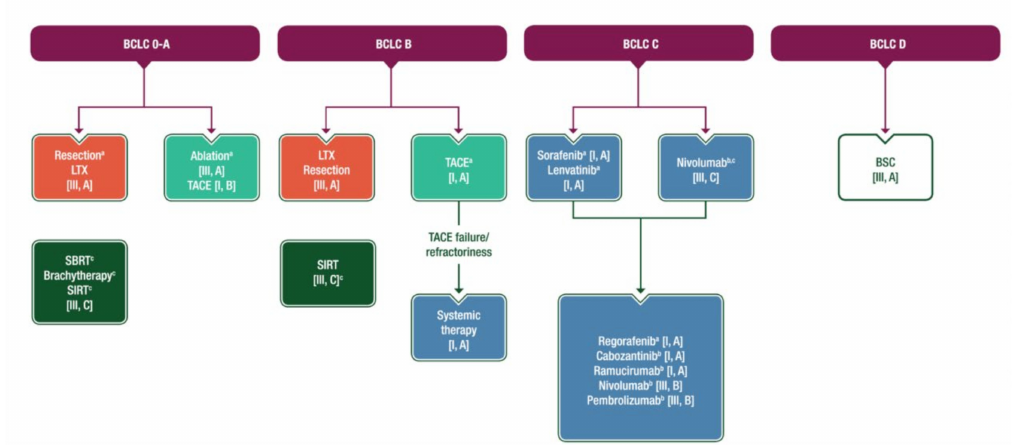
Figure 7. eUpdated European Society of Medical Oncology (ESMO) guideline on hepatocellular carcinoma algorithm on 19 June 2020. Reprinted from Ref. [101]. An Open Access article (CC BY